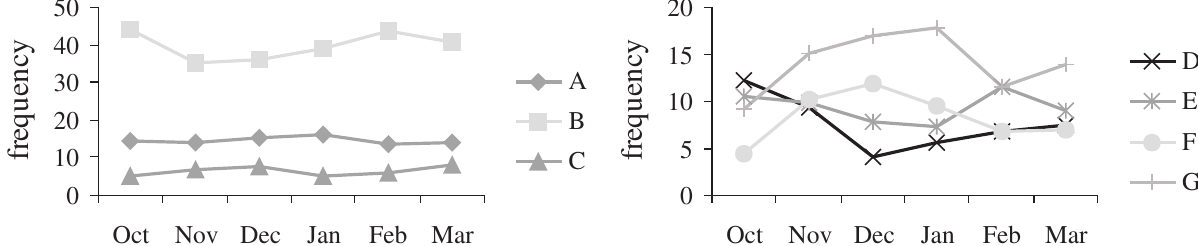
Fig . 5. – Monthly variation of the frequencies of occurrence of the identified landings profiles in the sample of fishing trips in the aegean